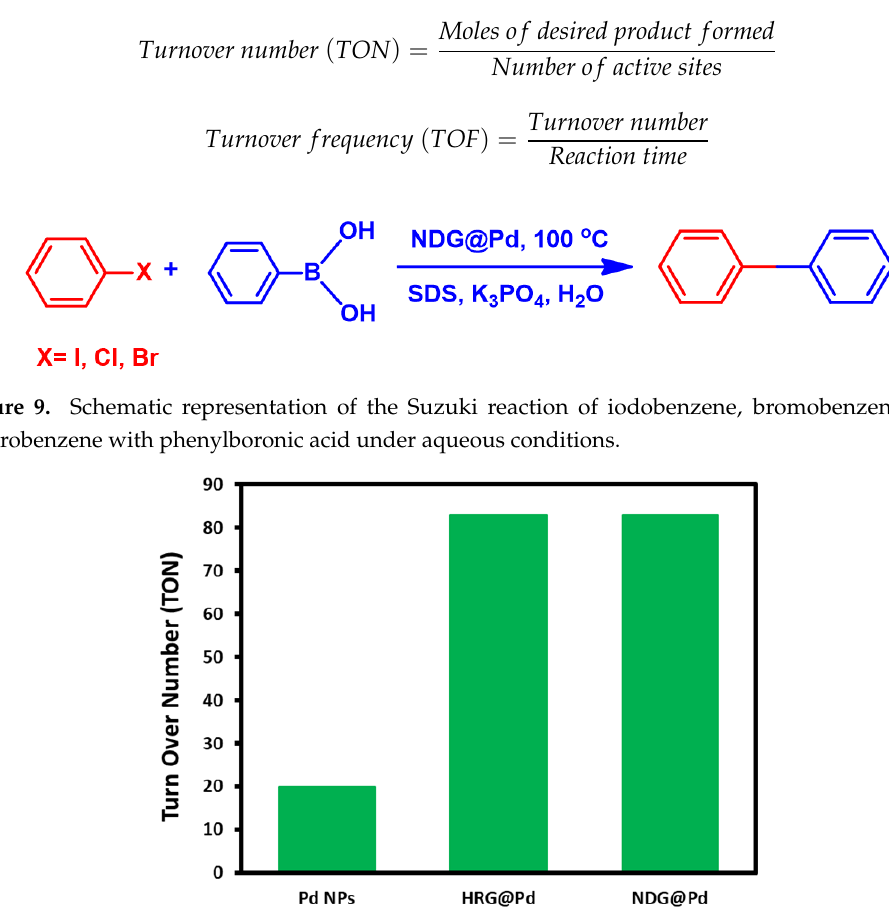
Figure 10. Graphical illustration of comparative turnover number (TON) values.